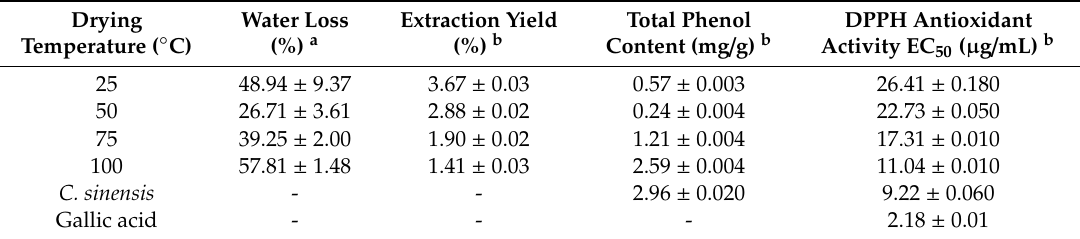
Table 1. Experimental results of M. zapota leaves dried at 25, 50, 75 and 100 ◦